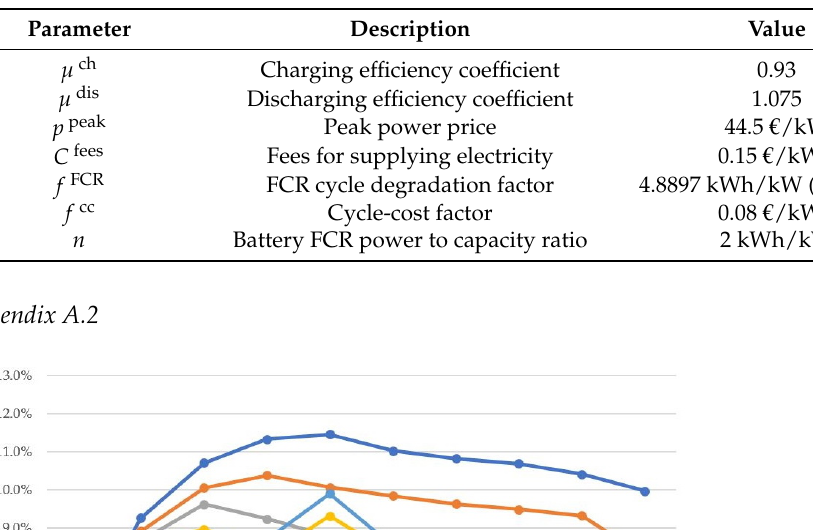
Table A1. Parameters values and description table.